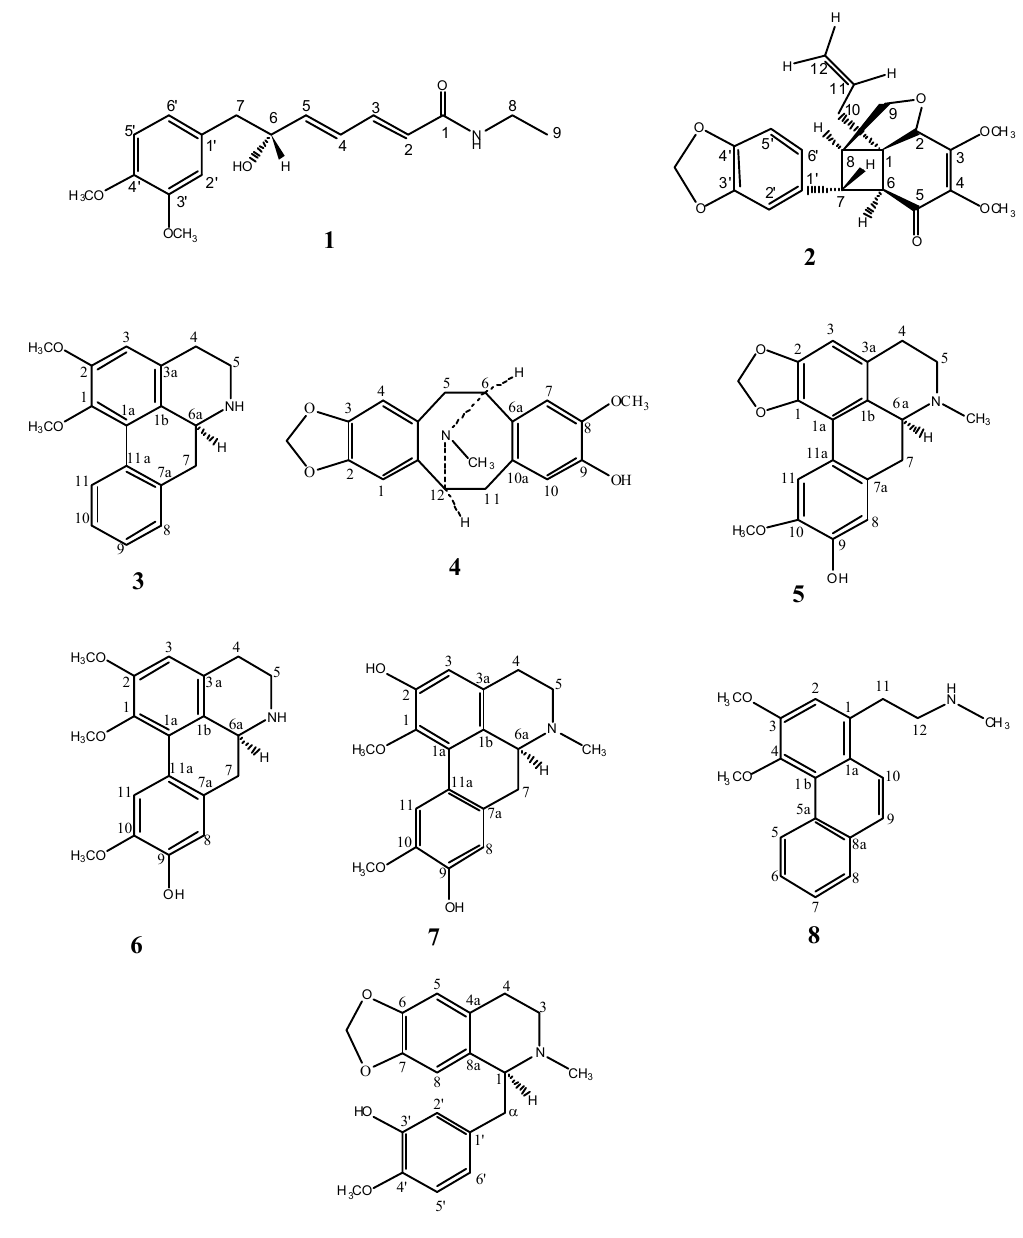
Figure 1. Chemical structures of compounds 1–9